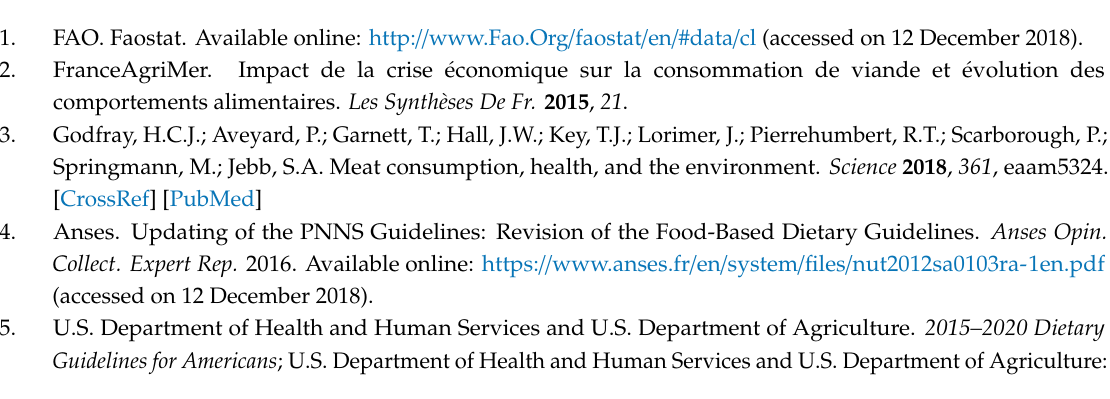
Table S1: Sociodemographic characteristics of the sample (n = 2055) after applying sample weights to ensure representativeness of the 2017 French population estimated by the French National Institute of Statistics and Economic Studies. Table S2: Associations between willingness to change and the dietary and socio-demographic characteristics of the individuals assessed using mixed models. Figure S1: Flow chart of the selection of reliable dietary data in the population sample (2018, n = 2055). Figure S2: Mean food intake of the clusters of protein food intake identified in the population sample (2018, n =